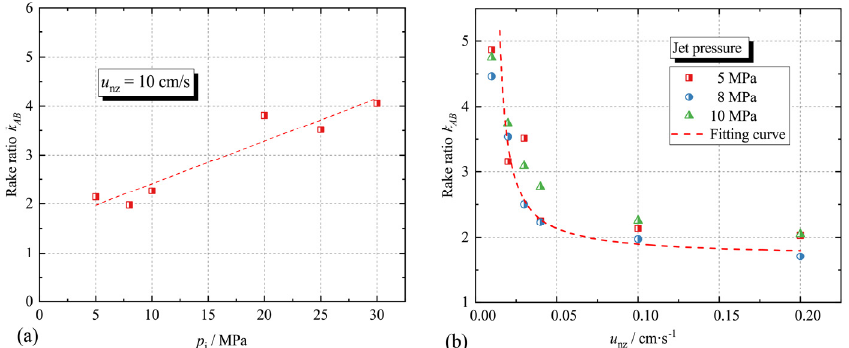
Figure 13. Relationship between the slope of the straight line and jet pressure and between the slope of the straight line and moving speed: ( a ) the relationship between slope and jet pressure under the premise of fixed nozzle moving speed of 10 cm/s; ( b ) the relationship between slope and nozzle moving speed under the premise of fixed jet pressure of 5, 8 and 10 MPa.